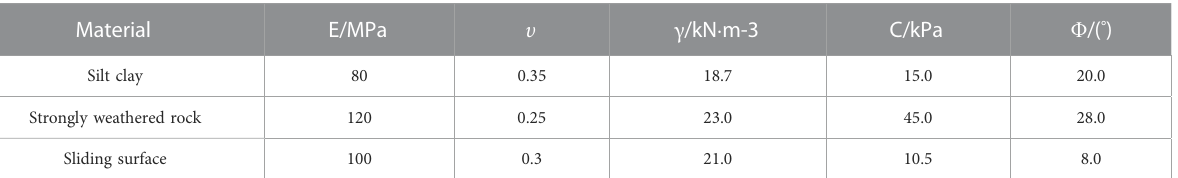
TABLE 2 Physical and mechanical parameters.